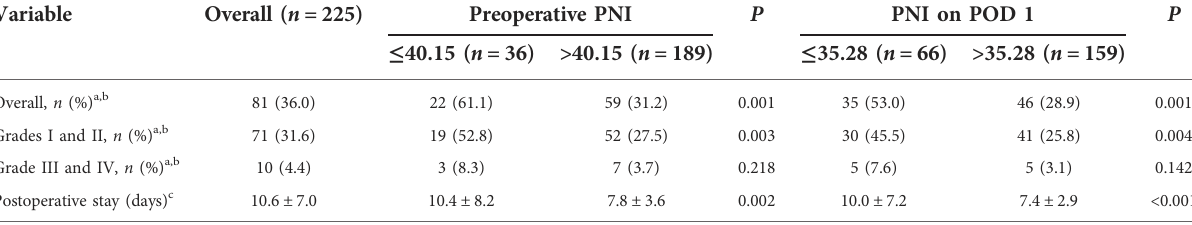
TABLE 4 Comparison of surgical complications in different PNI groups.